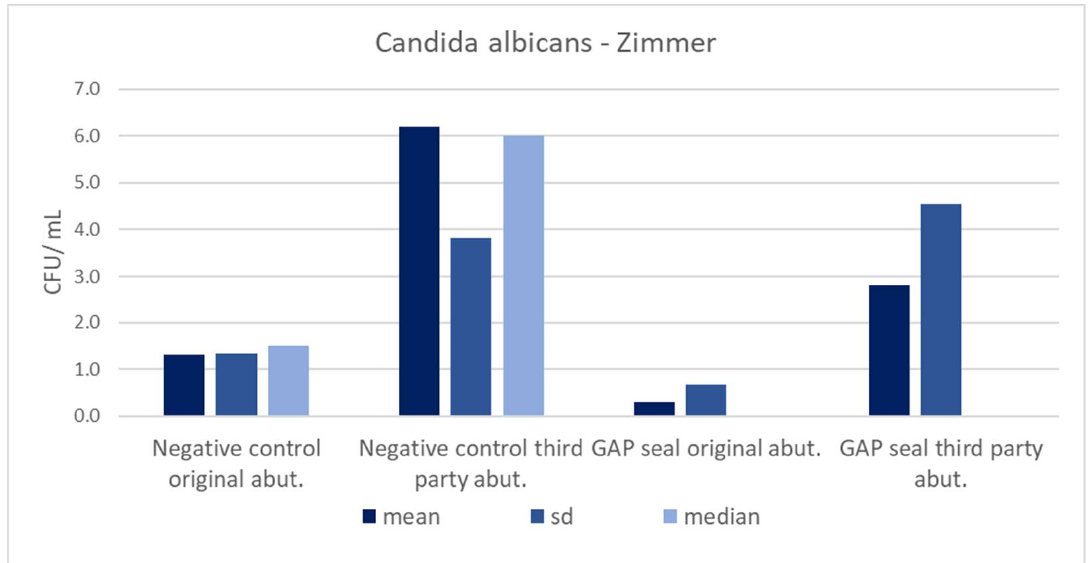
Figure 11. Mean counts of Candida albicans detected on the internal surface of Zimmer implants depending on the abutment fabrication method (original and third-party) and the need for the use of the gap sealing material.